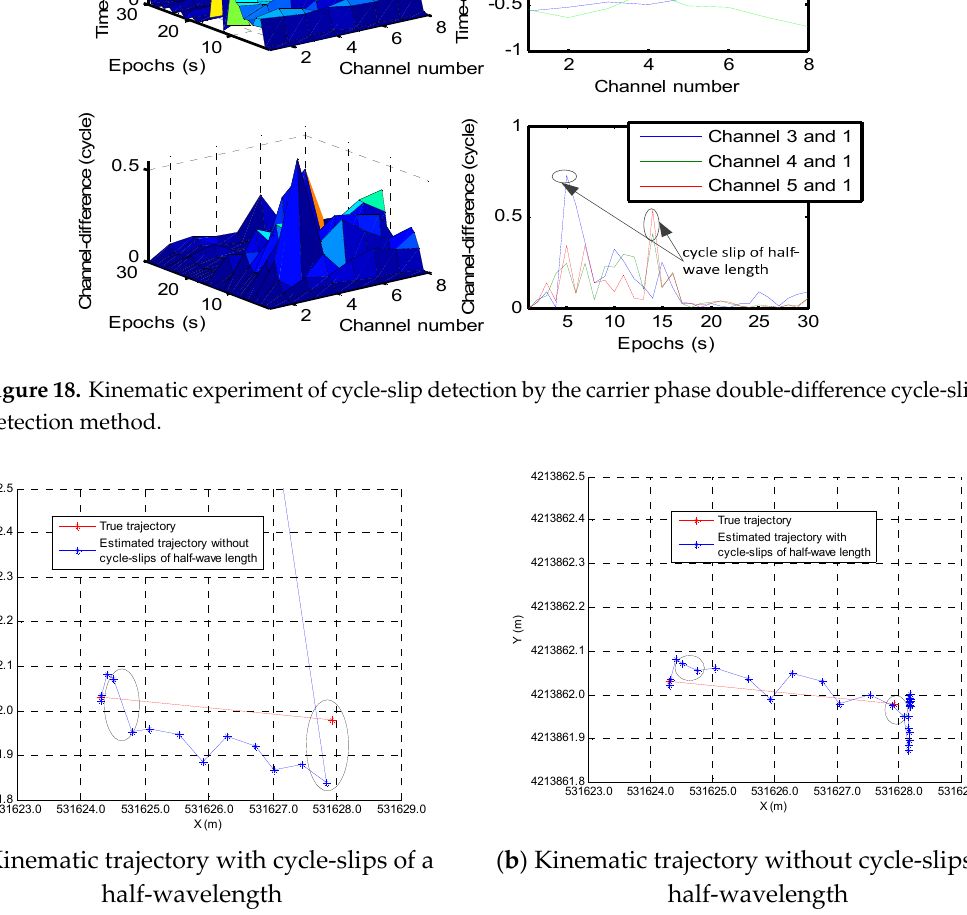
Figure 18. Kinematic experiment of cycle-slip detection by the carrier phase double-difference cycle-slip detection method.